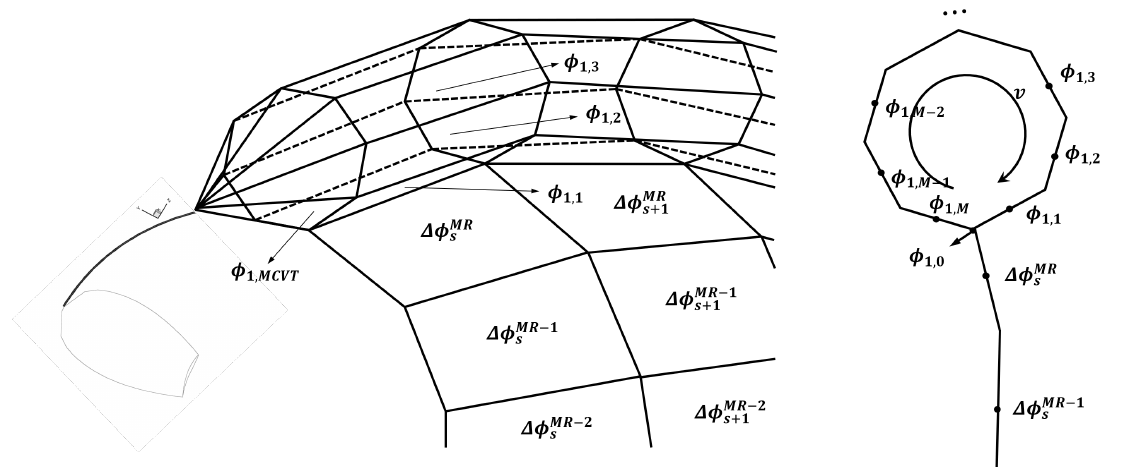
Figure 7. Potentials around the tip vortex cavitation in connection with the wake surface ( left ), and its cross section view with arrangement of the potentials calculated by Equation (24) along the v direction ( right